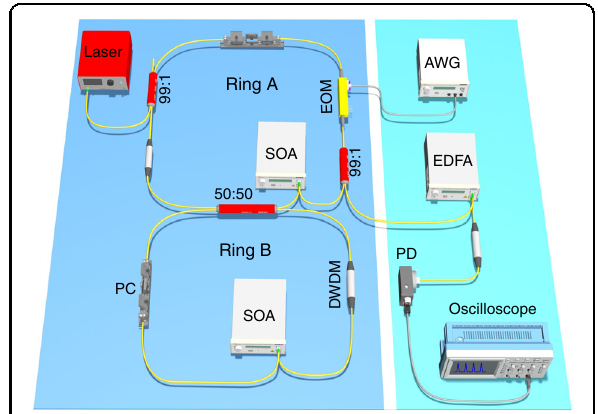
Fig. 2 Experimental setup. Ring A and ring B are coupled by a 2 × 2 fi ber coupler. EOM: electro-optic phase modulator. SOA: semiconductor optical ampli fi er. PC: polarization controller. DWDM: dense wavelength division multiplexing. AWG: arbitrary waveform generator. EDFA: erbium-doped optical fi ber ampli fi er.